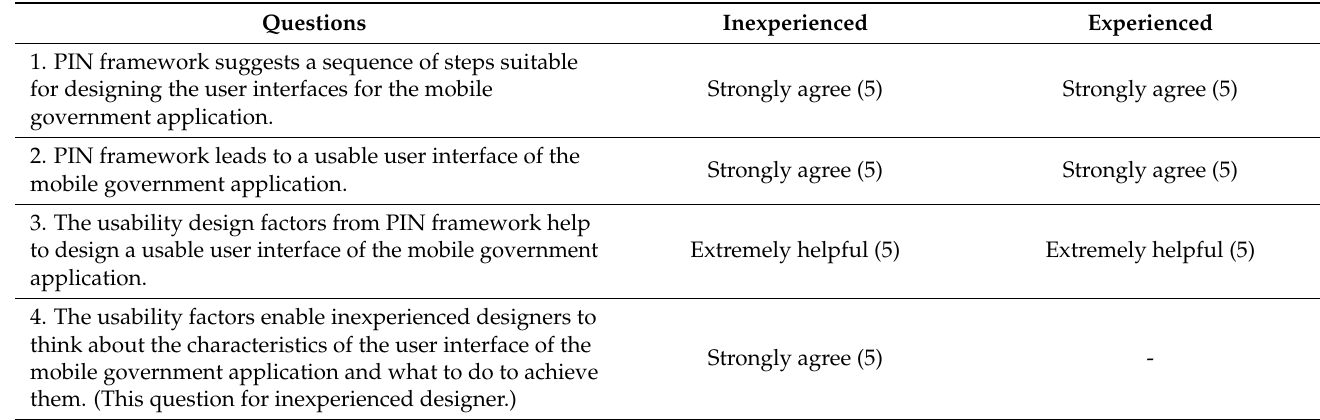
Table 10. The questions for the designers who used PIN